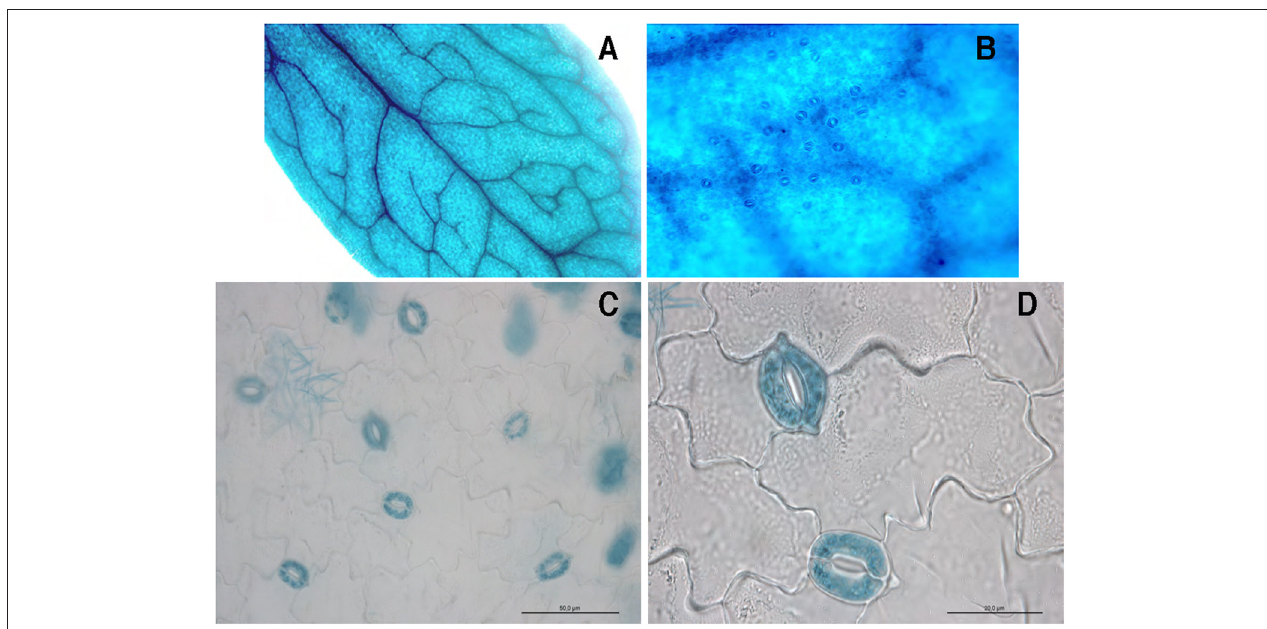
FIGURE 1 | Optical microscopy of a representative leaf of L. japonicus transgenic plant transformed with the pr LjGLB1-gus A construct. (A) Whole mount leaf showing staining in central and lateral veins and mesophyll cells. (B) Higher magnitude of leaf in (A) showing stained guard cells. (C) Peeled epidermis strip after staining. (D) Higher magnitude of epidermis strip in (C)